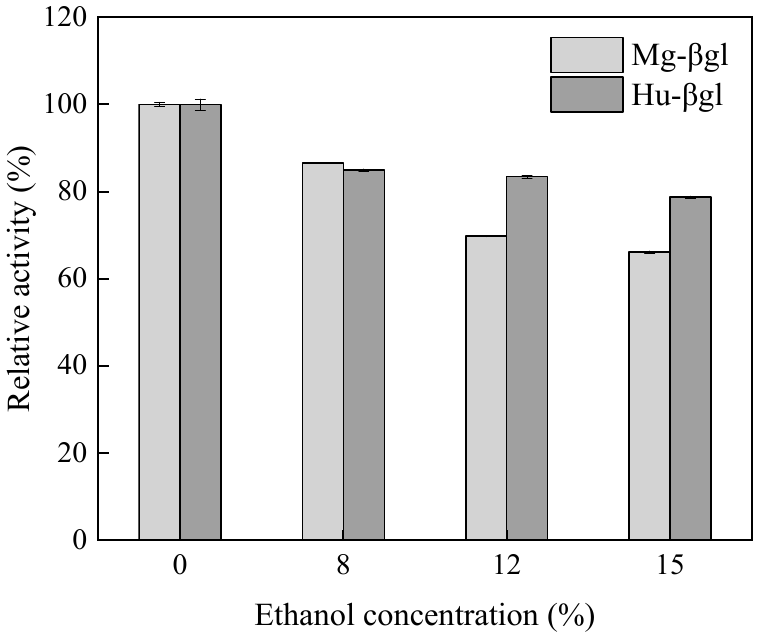
Figure 3. Effect of ethanol concentration on purified enzyme Mg- β gl and Hu- β gl. The values represent the mean of three replicate determinations. The error bars represent SD.